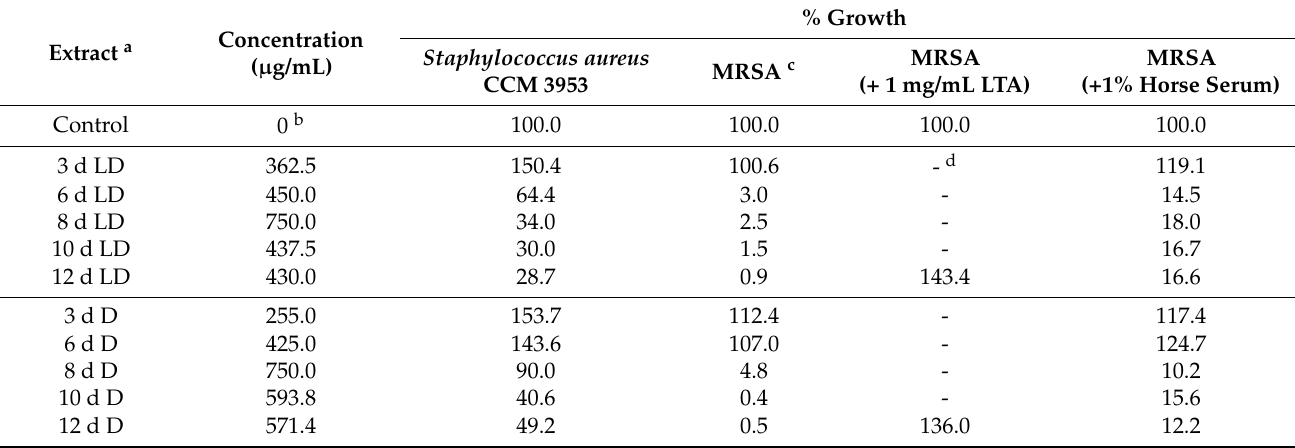
Figure 3. Mass spectra of short peptides isolated from the culture of T. atroviride O1 cultivated in constant darkness (organized in rows). Day of cultivation from the top—2nd, 3rd, 5th, 6th, and 12th. Atroviridins spectrum ( m / z between 1900 and 2000) was first detected on the 6th day of cultivation (fourth row). Table 1. The growth of Gram-positive bacteria in the presence of peptaibol-containing extracts of Trichoderma atroviride O1 and in combination with lipoteichoic acid (LTA) or horse blood